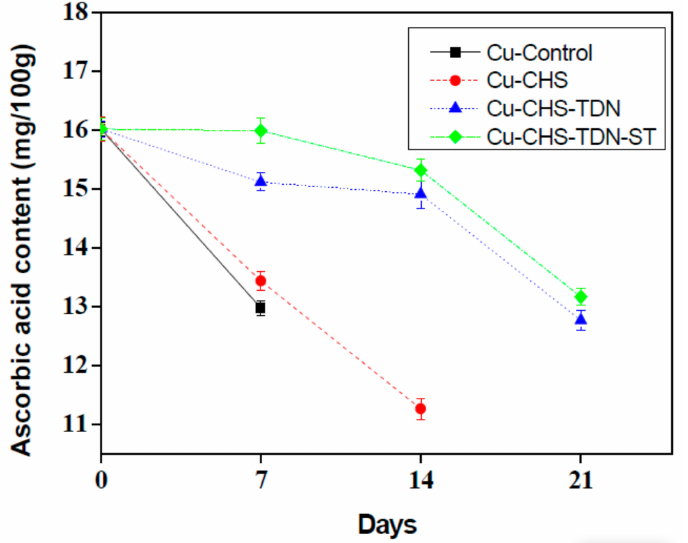
Figure 2. Effect of coating treatments on respiration